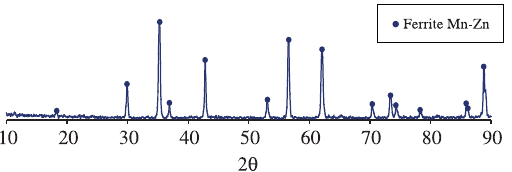
Zn Fe O ferrite 0,66 0,34 2 4